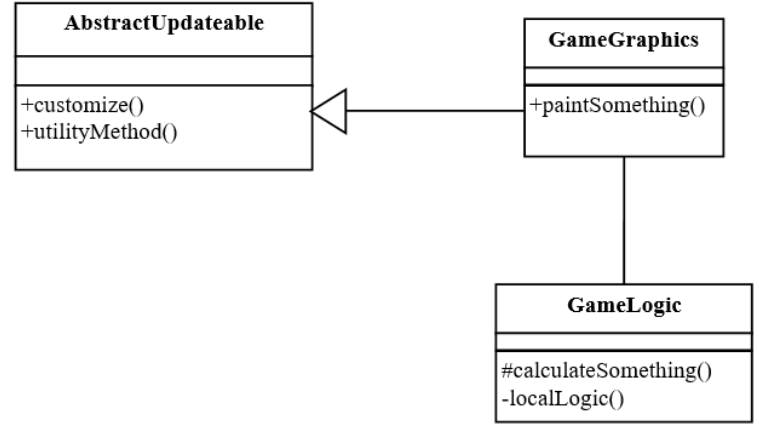
Figure 17. Single Platform pattern.